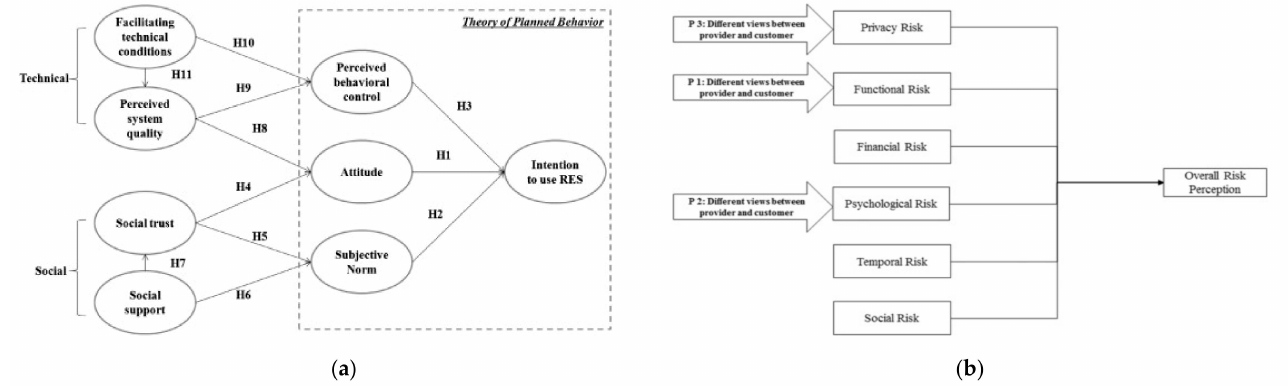
Figure 2. ( a ) Theory of planned behaviour with integrated socio-technical factors [16]. ( b ) A conceptual model presenting the drivers of perceived risk